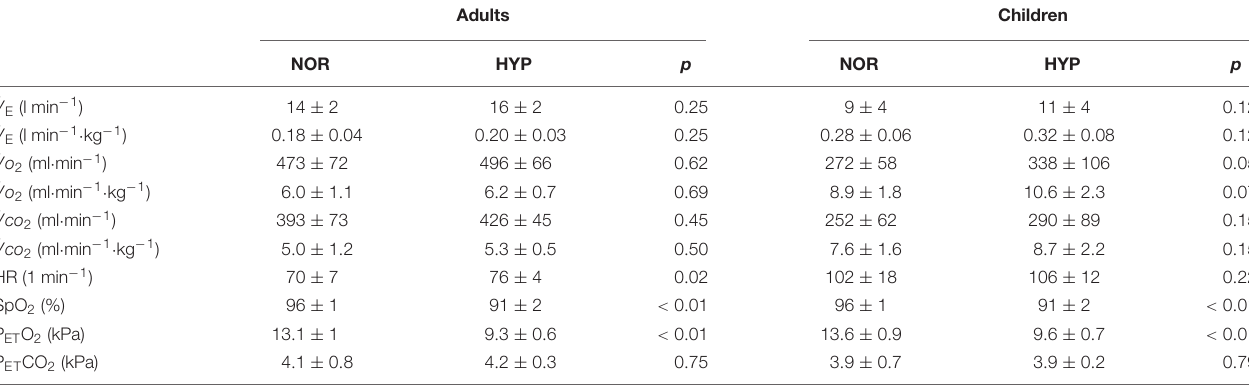
TABLE 1 | Pre-exercise resting values of the measured cardiorespiratory parameters in adults and children. Adults Children NOR HYP